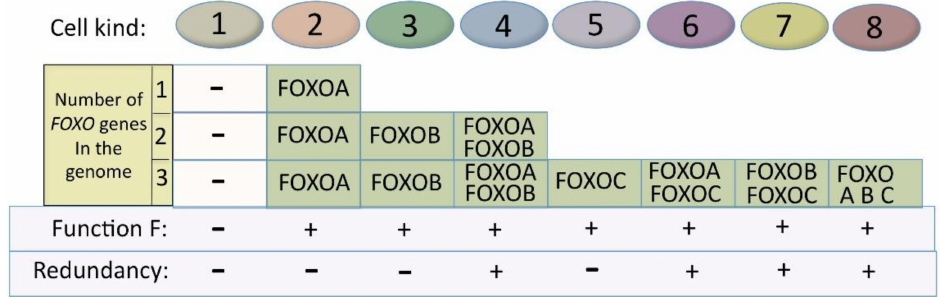
Figure 6. Increase in FOXO gene numbers increases the number of cell kinds (that can include several cell types) that express Function F and the number of cell kinds redundant for